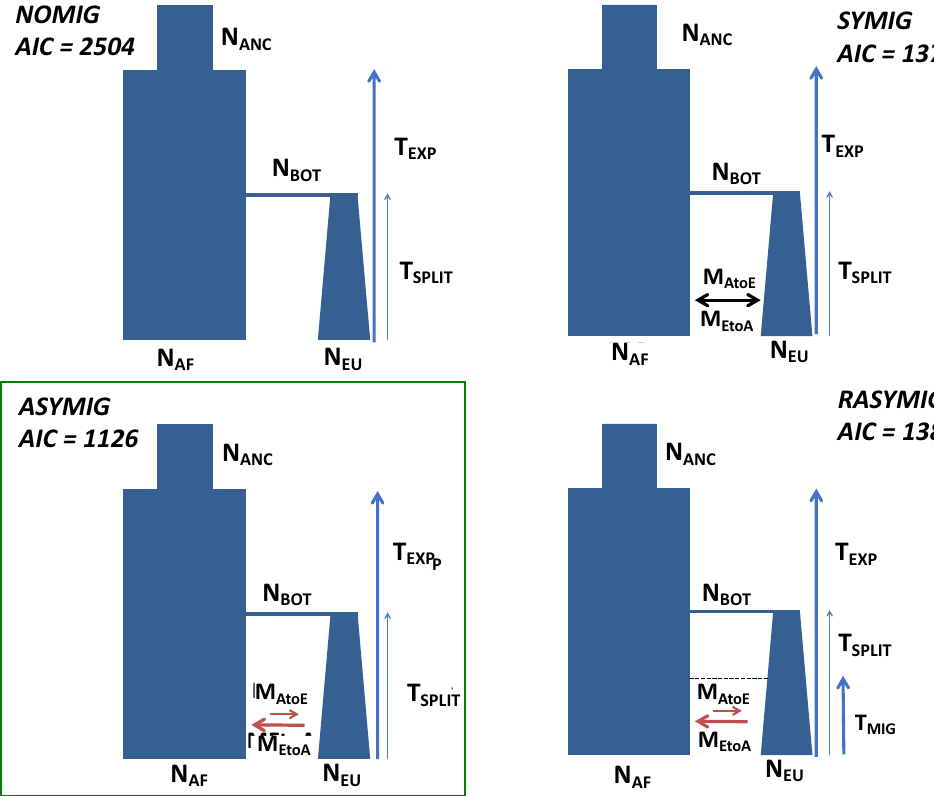
Figure 2. Results of the model choice analyses with the four demographic models tested in this study. Lowest AIC out of 10 replicates are reported for each model (autosomal data only). The green box with a continuous line indicates the best model for the autosomal and X-chromosomal data. Abbreviations in the figures are explained in the Materials and Methods section and Table